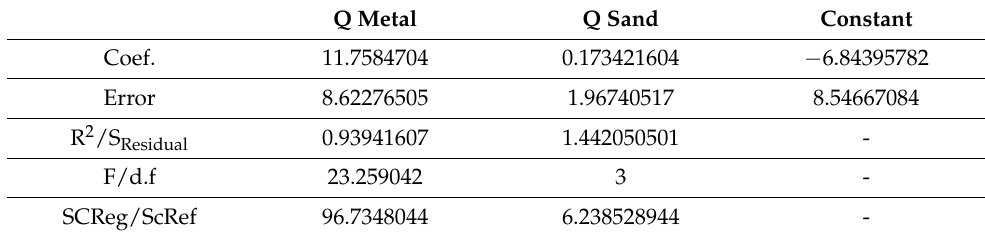
Table 1. Mathematical equation obtained by the correlation of the flows and the addition of water. Q Metal Q Sand Constant Coef. Q Metal Q Sand Coef.